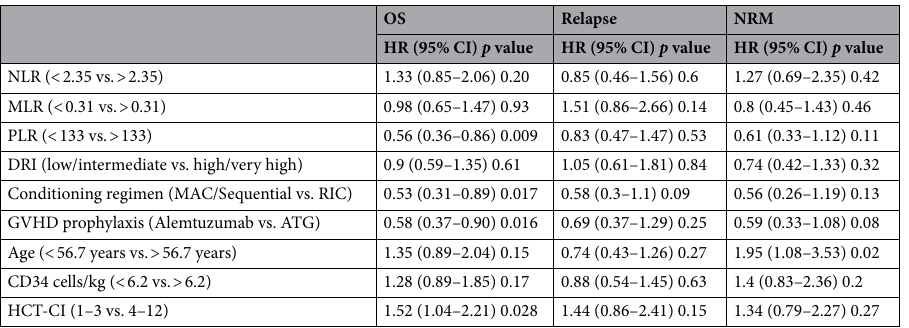
Table 2. Multivariate analysis for OS, Relapse and